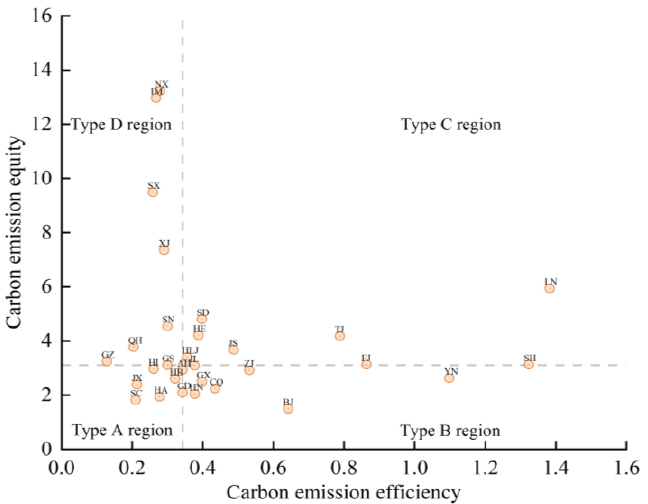
Figure 4. “Equity-efficiency” path matrix of carbon emission reduction. In the picture, we use BJ to represent Beijing, and so on for the other